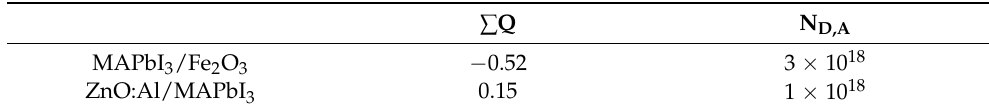
Table 2. Charge transfer ( ∑ Q) and number of donor and acceptor electrons (N D,A ) within MAPbI 3 /Fe 2 O 3 and ZnO:Al/MAPbI 3